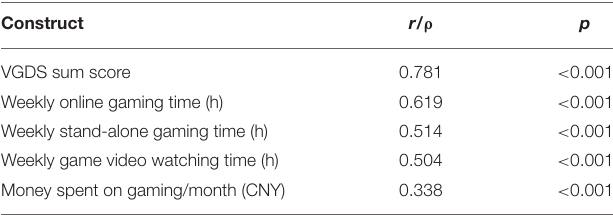
TABLE 4 | Correlations between GDSQ-21 and other related measures.